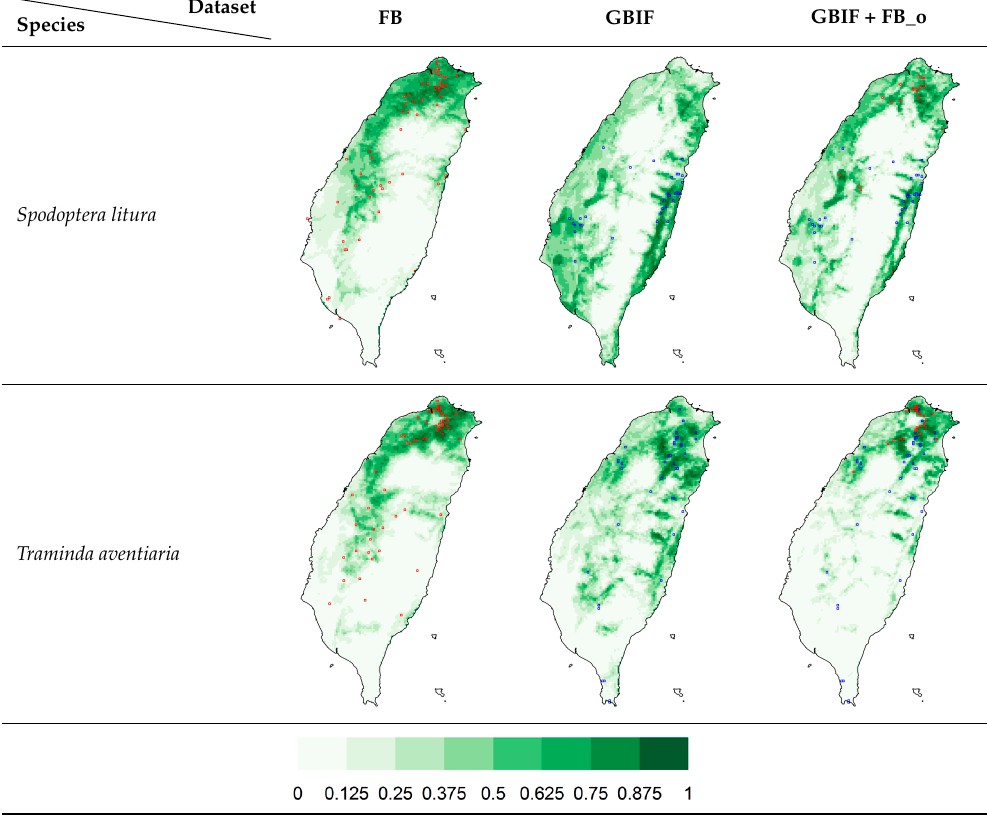
Table 3 shows the Pearson correlation coefficients between species distributions based on the GBIF dataset and alternative combinations of various selected datasets. The SDM output averages based on the GBIF dataset and combinations of the GBIF dataset plus optimal selected or random selected opportunistic datasets are highly